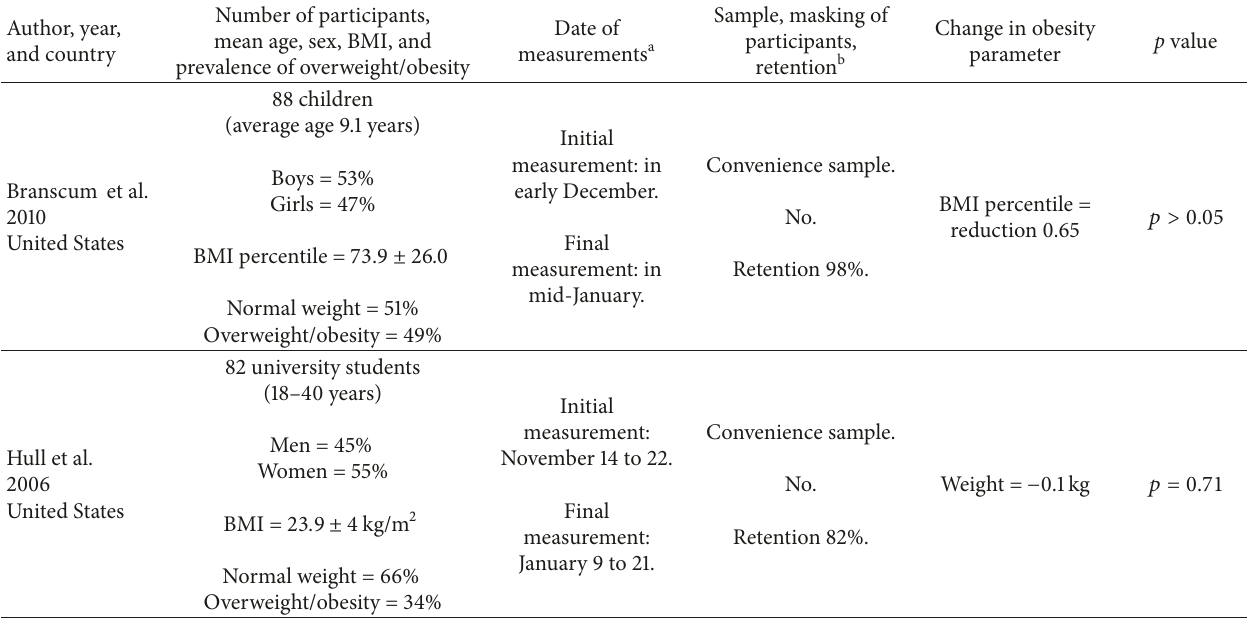
Table 3: Studies evaluating the effect of the holiday period on body weight in children and college